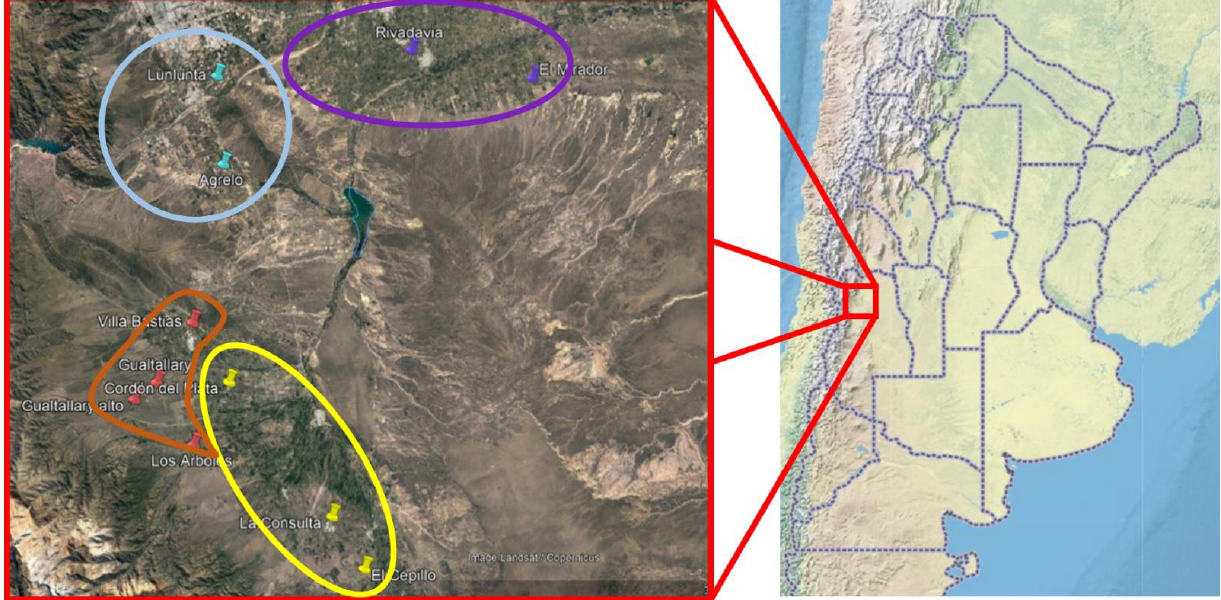
Figure 1. Grapevine sampling across four sites in North Mendoza. East (purple), Primera Zona (light blue), Lower Valle de Uco (yellow), and Upper Valle de Uco (orange).